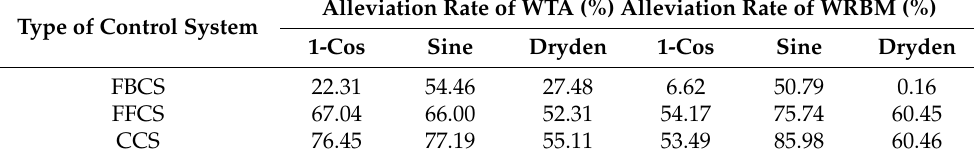
Table 2. Comparison of alleviation rate of different types of gusts (simulation results).